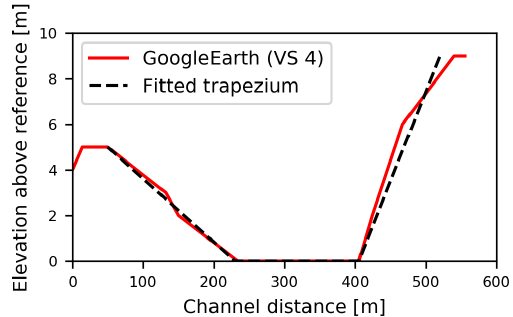
Figure 4. Example of approximating a trapezoidal cross section (black) into the Google Earth based cross-section data (red) for vir- tual station “VS 4” (see also Fig. 1a and Fig. 3). The reference level is equal to the lowest water level in the river profile.